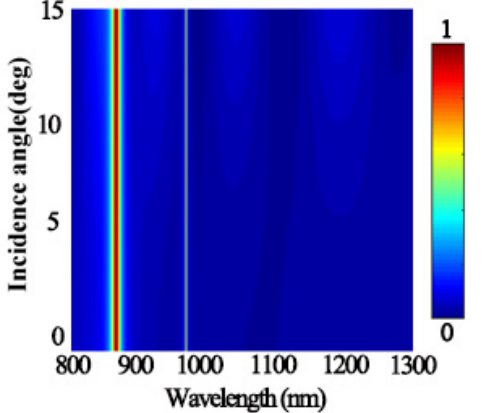
Figure 5. Corresponding resonance wavelengths at different incident angles.